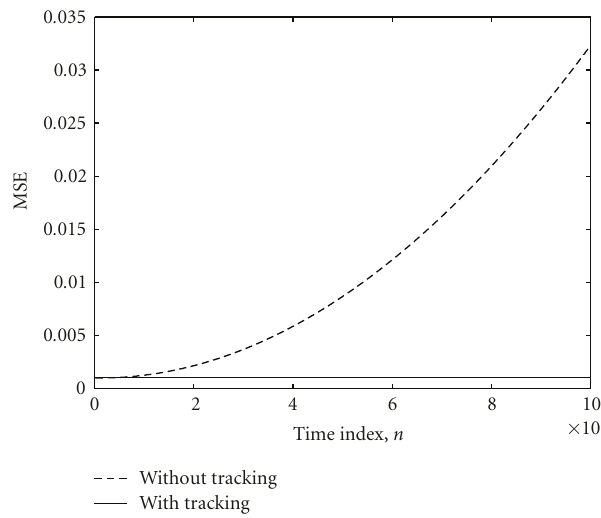
Figure 12: Mean square error at the output of an SMT receiver, averaged over all subcarriers, with and without a timing tracking loop.